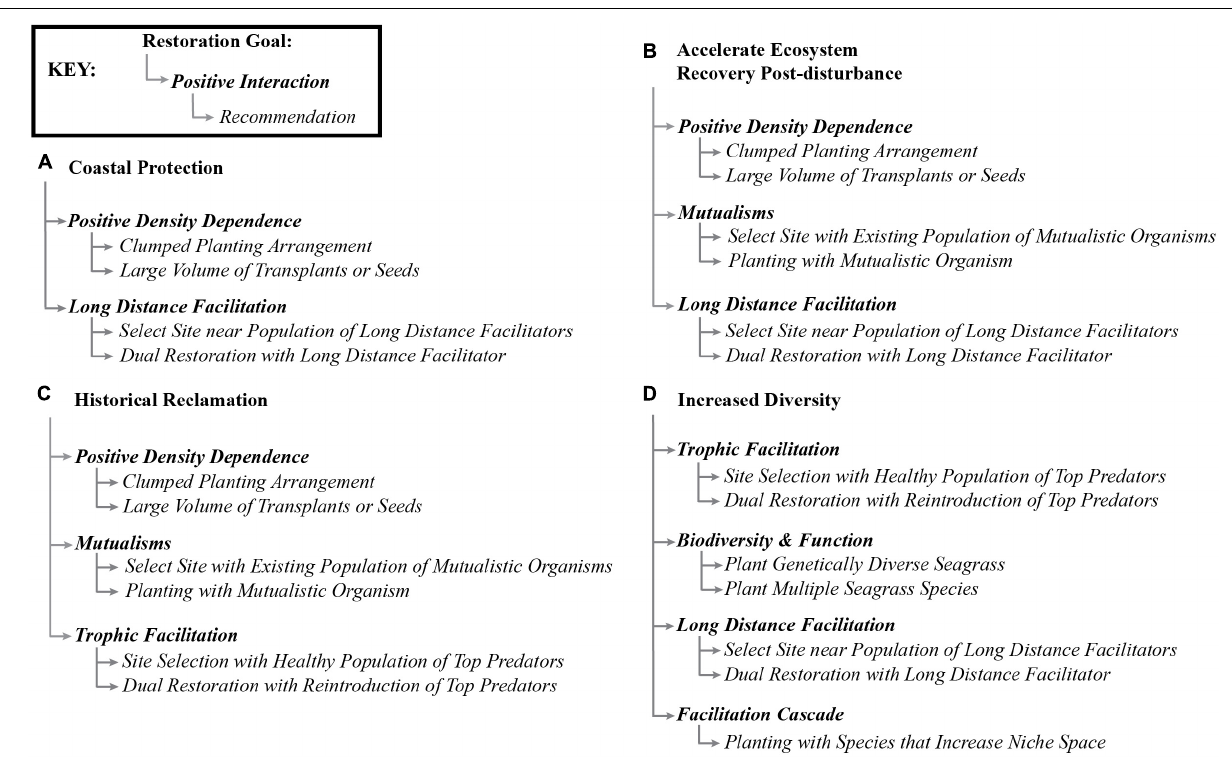
FIGURE 5 | Conceptual map of some common restoration goals (Yap, 2000) and the positive interactions that could be used to accomplish such goals, and brief recommendations of how to explore the positive interactions as a starting point for researchers and